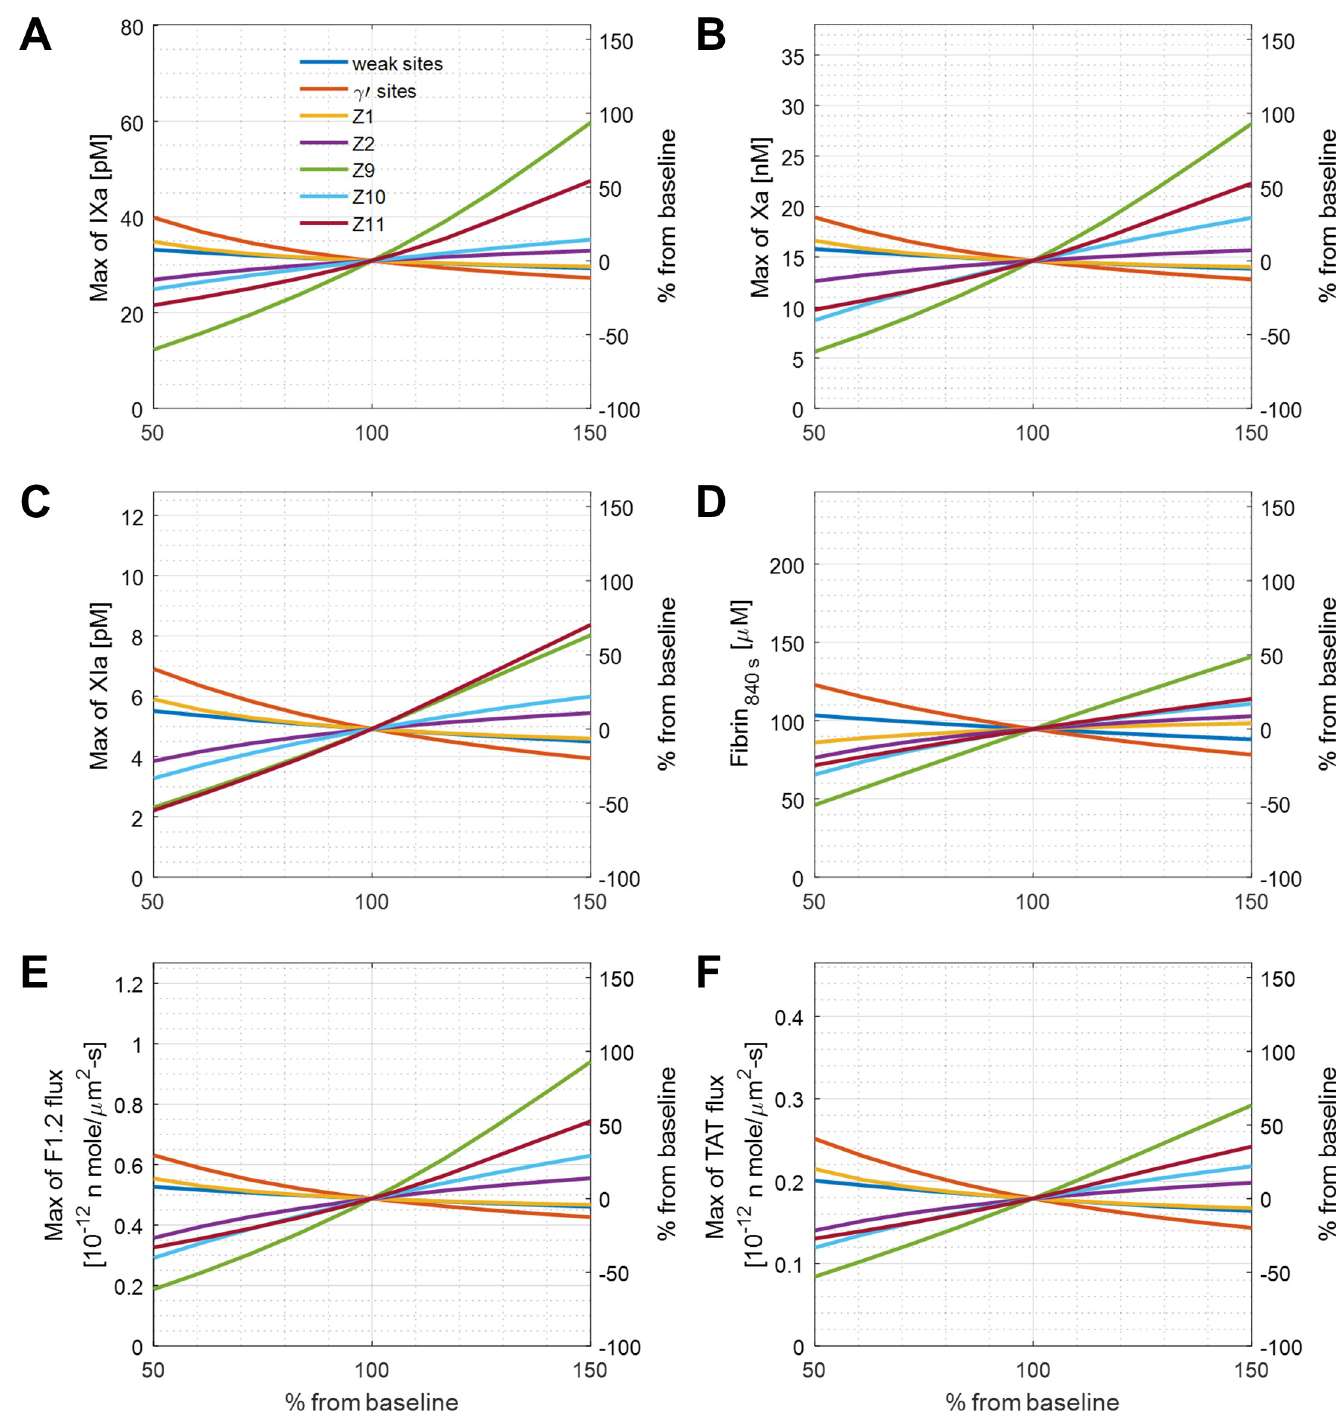
Fig 3. Local sensitivity analysis of procoagulants, fibrin, F1.2 flux, and TAT flux. The concentration change of FIXa (A), FXa (B), FXIa (C), fibrin (D), and flux of F1.2 (E) and TAT(F) due to the variation of plasma protein levels or thrombin binding sites on fibrin. The levels were changed one-at-a-time.